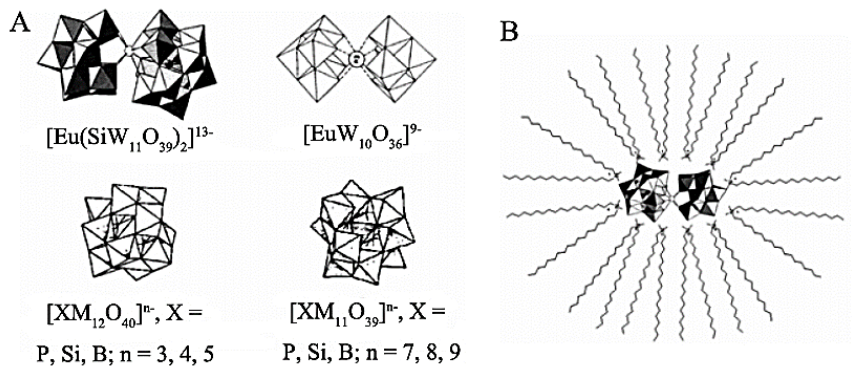
Figure 15. Schematic drawings of the structures of SECs series ( A ) and the SEC-1 structure ( B ), with copyright permission from